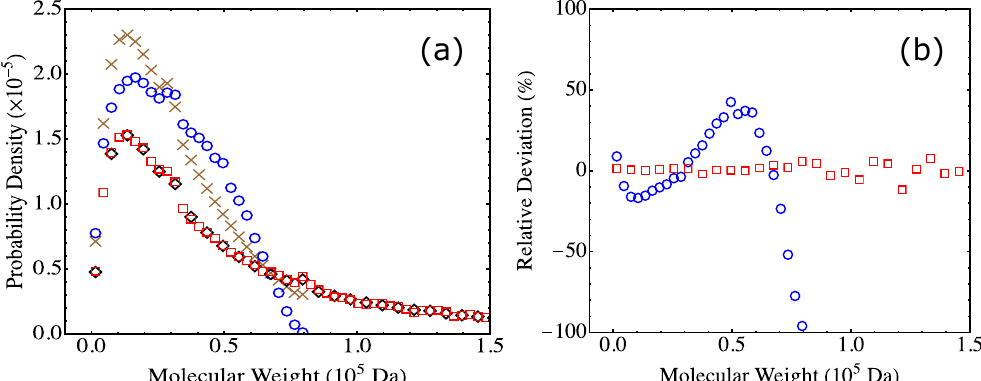
Figure 7. ( a ) MWD with data from for the Flory-Stockmayer theory for S 1 (brown crosses), the MC simulations for S 1 (blue circles), the Flory-Stockmayer theory for S 80 (black diamonds), and the MC simulations for S 80 (red squares). The MC results are averages of 50,000 runs for S 1 and 1000 runs for S 80 (as well as S < , S 10 , and S 50 ). ( b ) The relative deviation of the MC results from the prediction of the Flory-Stockmayer theory for S 1 (blue circles) and S 80 (red